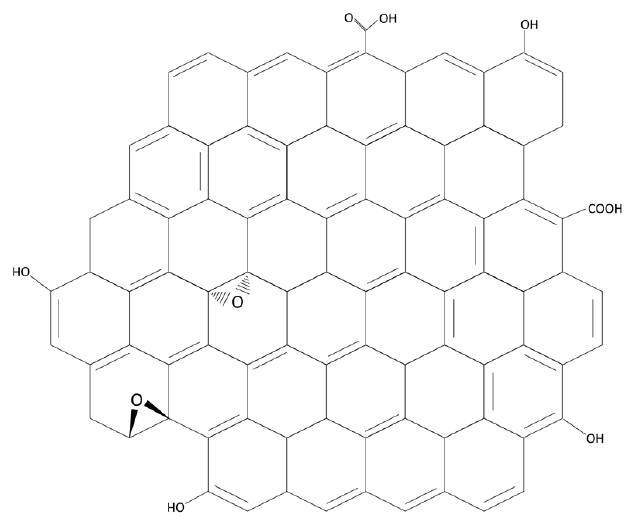
Figure 1. Graphene oxide (GO) structure.